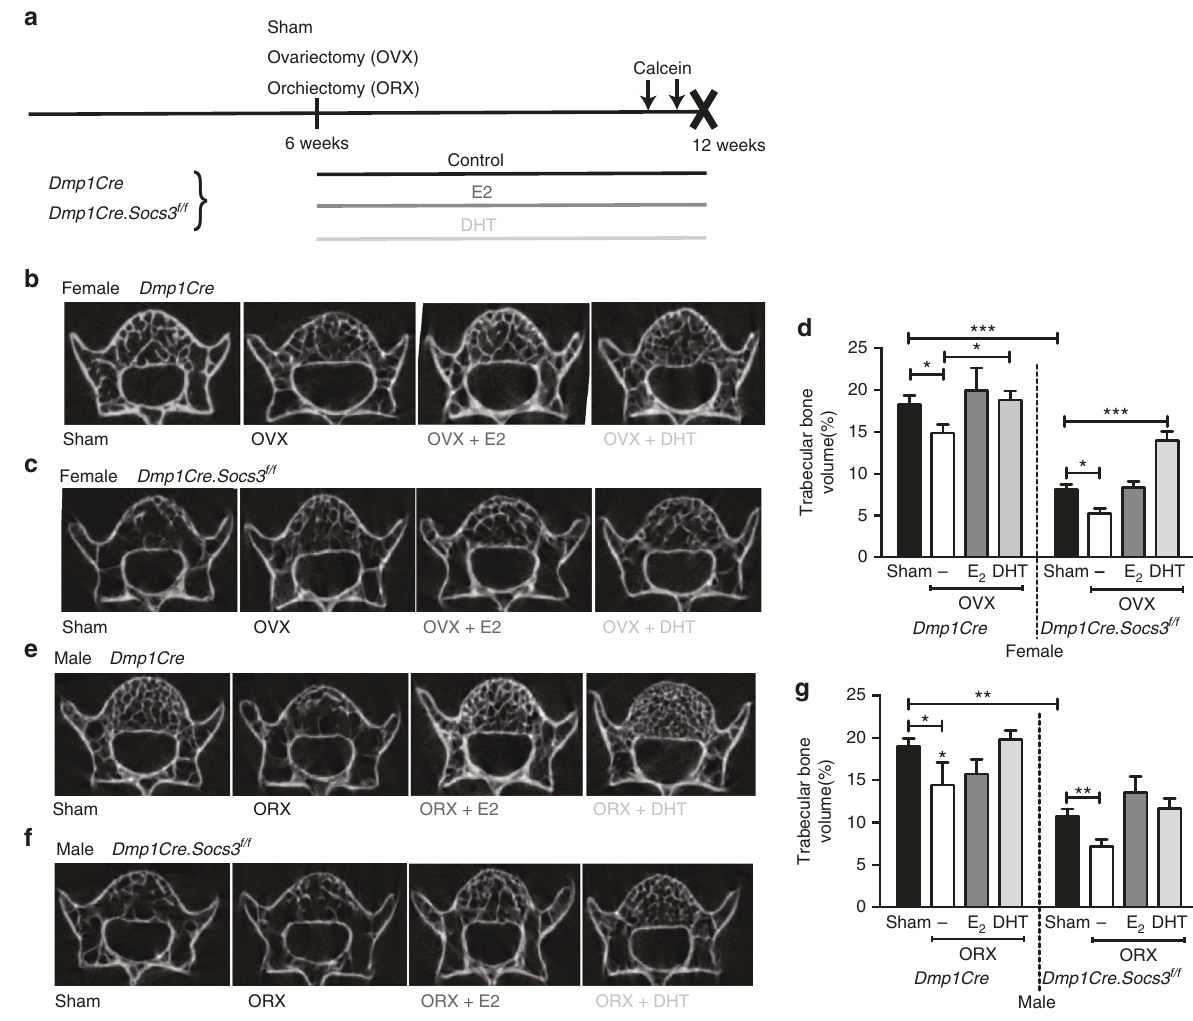
Fig. 5 Sex hormone treatment protects against gonadectomy-induced trabecular bone loss in the 5th lumbar vertebrae of female and male Dmp1Cre.Socs3 f/f and Dmp1Cre mice. a Schematic showing experimental protocol including sham operation, ovariectomy (OVX), or orchiectomy (ORX) at 6 weeks of age, and treatment with silastic implants of dihydrotestosterone (DHT) or estradiol (E 2 ) from 6 – 12 weeks of age. b – g Micro-CT analysis including representative transaxial images of the 5th lumbar vertebrae of female Dmp1Cre ( b ), Dmp1Cre.Socs3 f/f ( c ), and male Dmp1Cre ( e ), Dmp1Cre.Socs3 f/f ( f ) mice from each treatment group and vertebral trabecular bone volume of female ( d ) and male ( g ) Dmp1Cre and Dmp1Cre.Socs3 f/f mice subjected to gonadectomy and steroid treatments as outlined in a . Values are mean + SEM, n = 6 per group. * p < 0.05; ** p < 0.01; ***, p < 0.001 for comparisons indicated in the fi